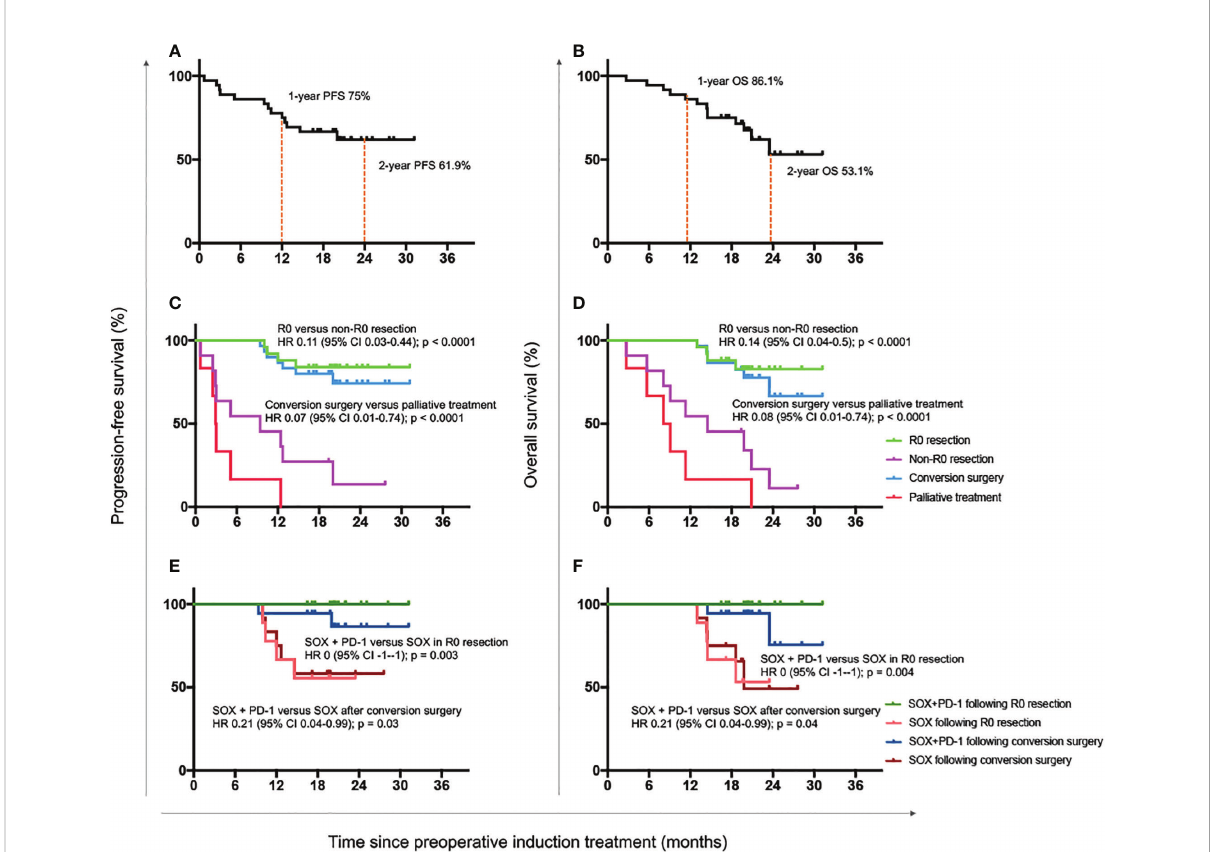
FIGURE 3 Progression-free and overall survival outcomes. Progression-free survival (A) and overall survival (B) of all enrolled 36 patients. Progression-free survival (C) and overall survival (D) of patients with R0 resection, non-R0 resection, conversion surgery and palliative treatment. Progression-free survival (E) and overall survival (F) of patients who received with the combination of SOX plus anti-PD-1 antibody or only the standard adjuvant chemotherapy regimen SOX after R0 resection or conversion surgery. OS, overall survival; HR, hazard ratio; CI, con fi dence interval; SOX, S-1 and oxaliplatin; PD-1, programmed cell